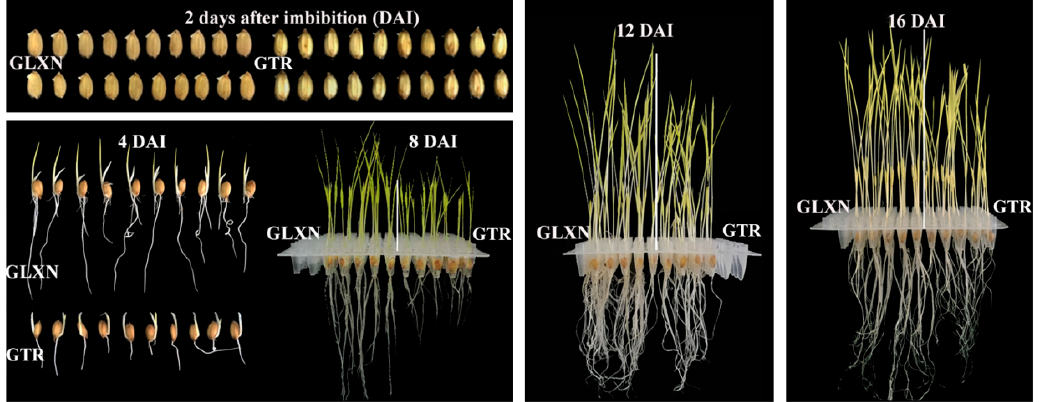
Figure 1. Photographs of rice grain germination and seedling growth in the dark only in deionized H 2 O.